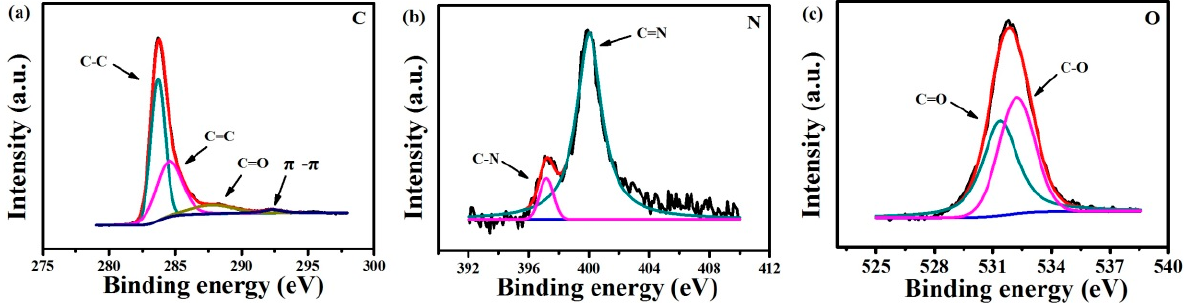
Figure 8. XPS ( a ) C, ( b ) N and ( c ) O spectra of